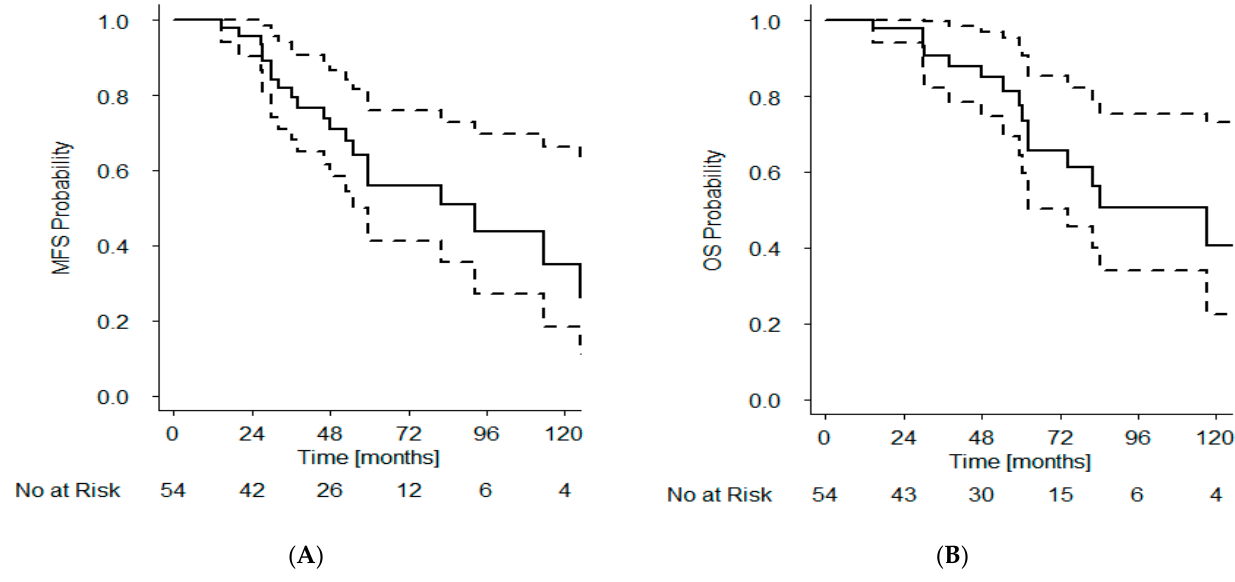
Figure 3. Kaplan–Meier estimate (solid line) and 95% confidence interval (broken lines) for MFS ( A ) and OS ( B ) for cohort